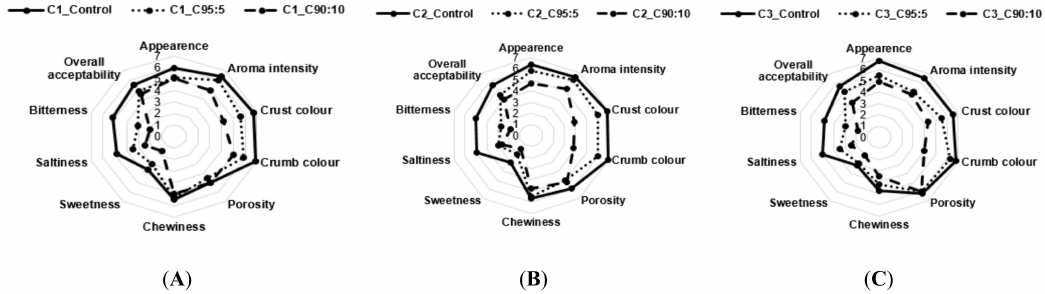
Figure 1. Sensory analysis of bread with BSG addition and di ff erent type of flours. ( A ) Bread with wheat flour 100% (C1_control), 95% wheat and 5% BSG composite (C1_95:5), 90% wheat and 10% BSG composite (C1_90:10) for the C1 sample; ( B ) Bread with wheat flour 100% (C2_control), 95% wheat and 5% BSG composite (C2_95:5), 90% wheat and 10% BSG composite (C2_90:10) for the C2 sample; ( C ) Bread with wheat flour 100% (C3_control), 95% wheat and 5% BSG composite (C3_95:5), 90% wheat and 10% BSG composite (C3_90:10) for the C3 sample.